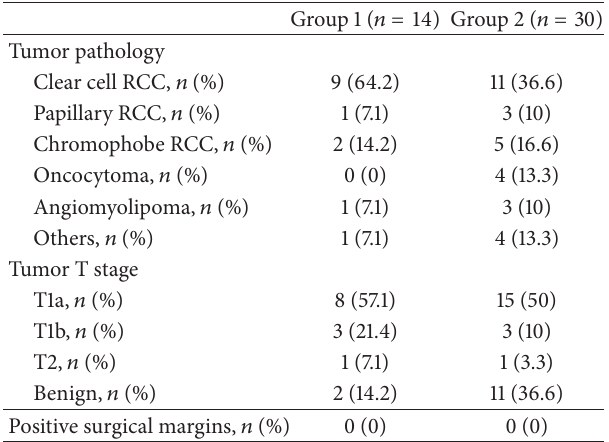
Table 2: Differences between group 1 and group 2 in terms of histopathologic variables. Group 1 ( 𝑛 = 14 ) Group 2 ( 𝑛 = 30